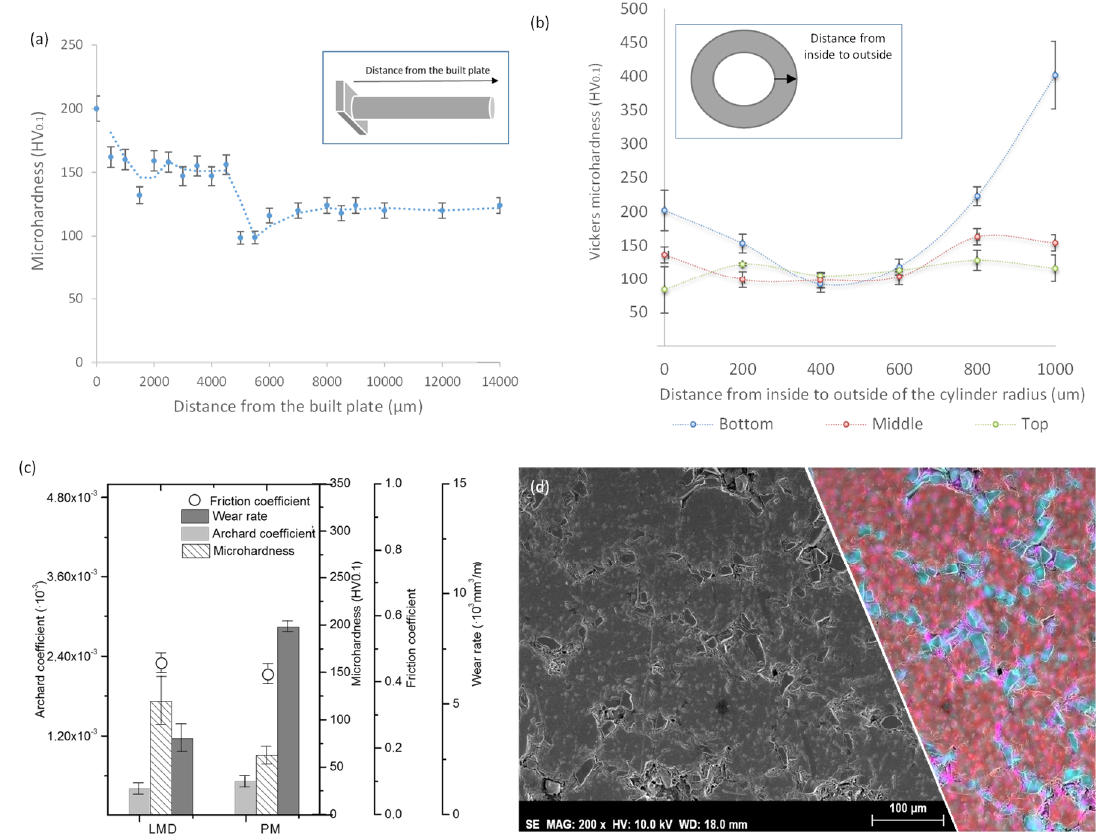
Figure 6. ( a ) Microhardness evolution across the cylinder longitudinal direction; ( b ) Microhardness evolution from inside to outside of the cylinder radius; ( c ) wear test measurements: wear rate (dark grey columns), Archard coefficients (light grey columns), microhardness (lined columns) and friction coefficients (circles) for PM and LMD samples; ( d ) PM sample microstructure, SE image and EDS elements map, color code: aluminum in red, silicon in cyan and, carbon in magenta.